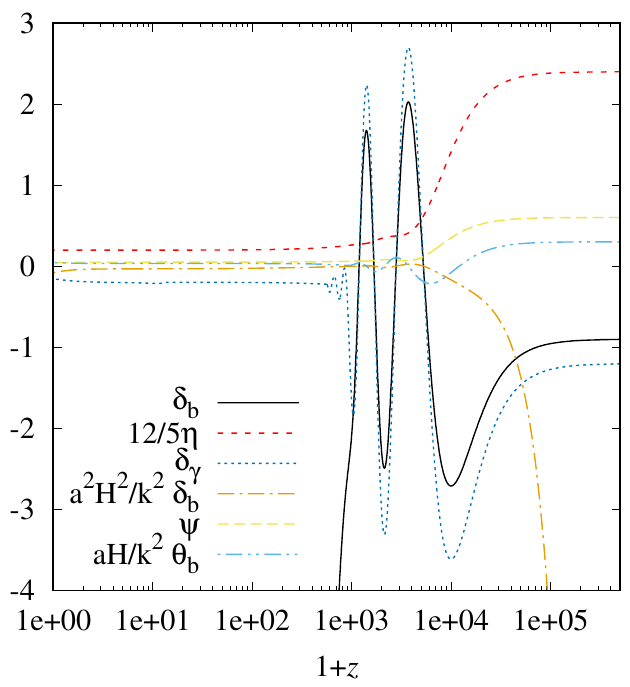
Figure 3. Evolution of perturbations out of which we can test the motivation of our study in the high k regime (fixing k = 0.1 Mpc − 1 ) at all times for the default values of the parameters. During radiation domination (when c 2 s should not be neglected) and up to z > 10 4 , η typically dominates over δ b , so that c 2 s k 2 η > c 2 s k 2 δ b , and this term cannot be neglected. Instead, δ γ dominates over δ b up to z > 10 3 , so that in this range of redshift c 2 s k 2 δ γ > c 2 s k 2 δ b . Therefore, such a term cannot be neglected in tight